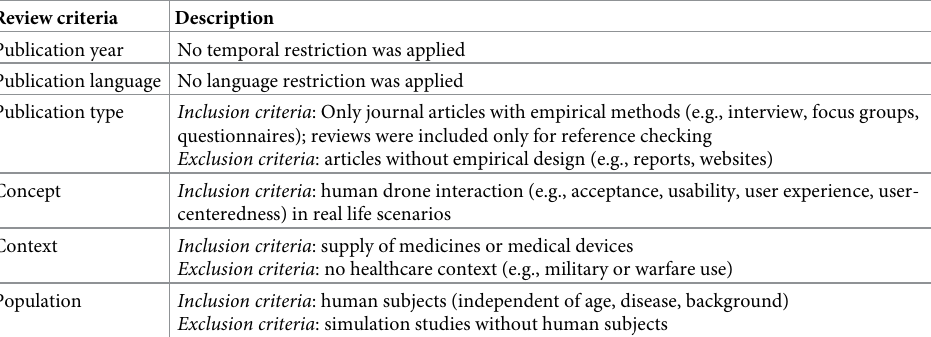
Table 2. Summary of review